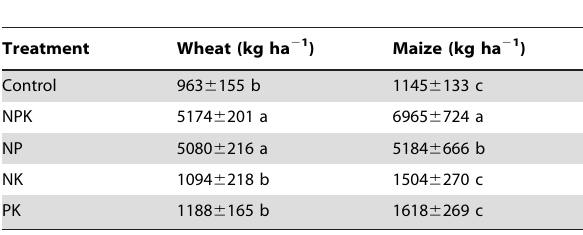
Table 3. Multi-year average grain yield of wheat and maize, as affected by various treatments with fertilizer in a wheat- maize rotation system at Yucheng, Shandong Province of China (mean 6 standard